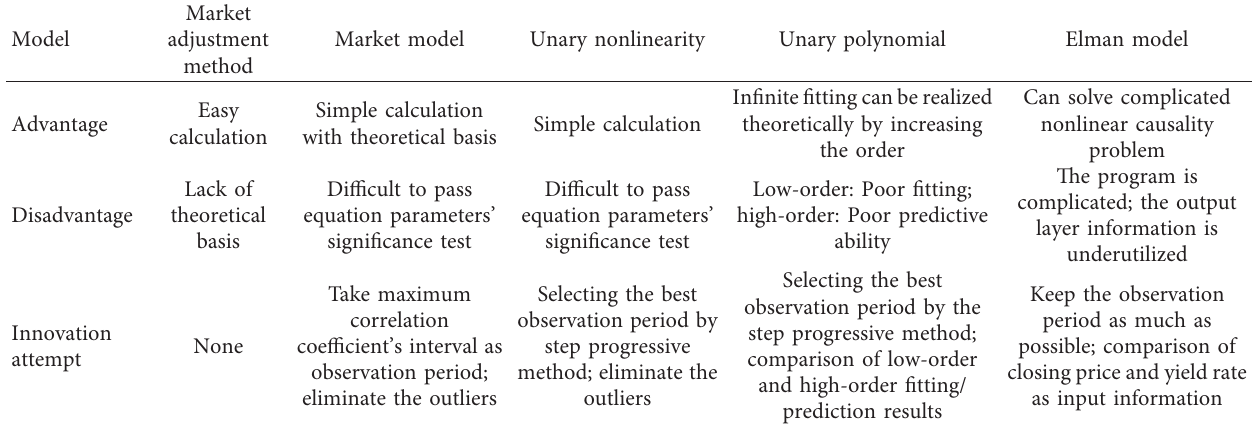
Table 7: Comparison of advantages and disadvantages of five AR